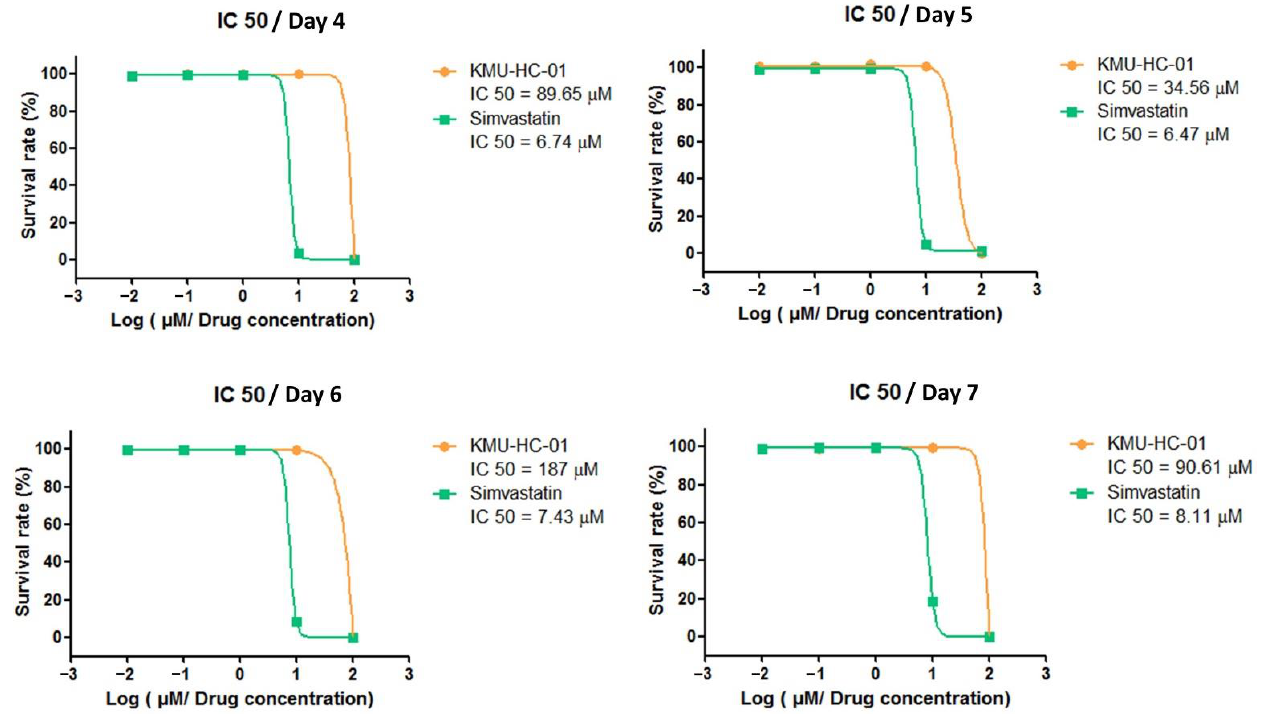
Figure 2. Cytotoxicity of simvastatin and KMUHC-01. Cell viability/IC50 of D1 cells treated with simvastatin/KMUHC-01 for 4 and 7 days were measured using the CCK-8 assay.